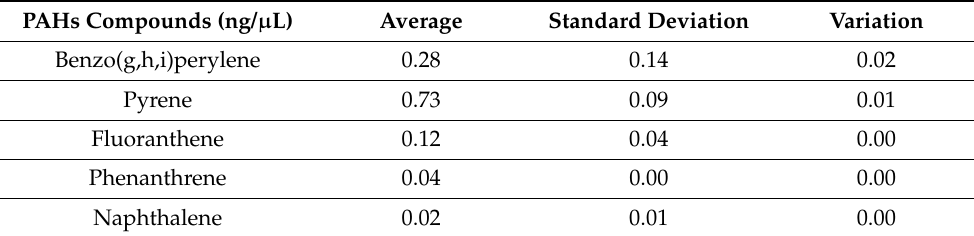
Table 3. Five different PAHs compounds were measured in tire samples. PAHs Compounds (ng/ µ